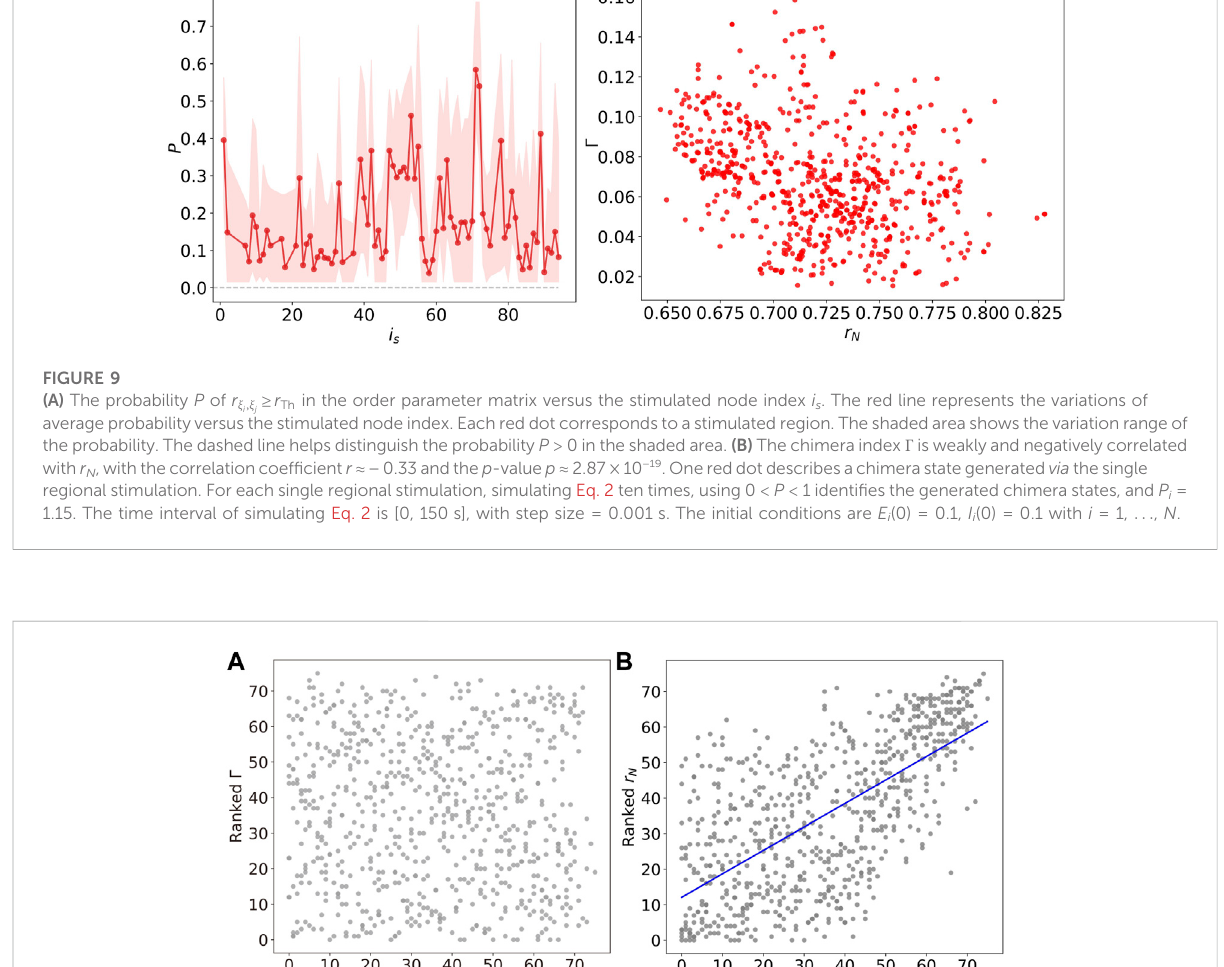
fi cient r ≈ 0.66 and the p -value p ≈ s , with the correlation coef